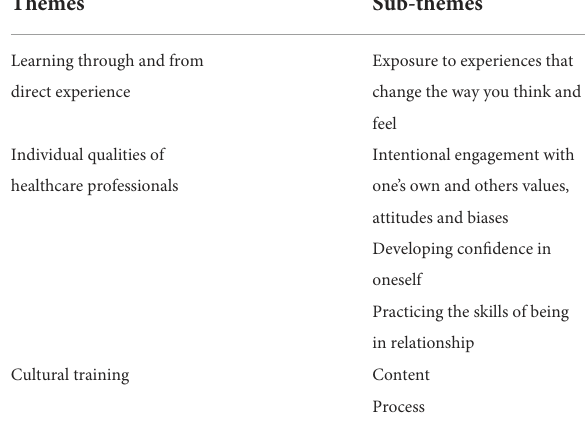
TABLE 3 Summary of themes and